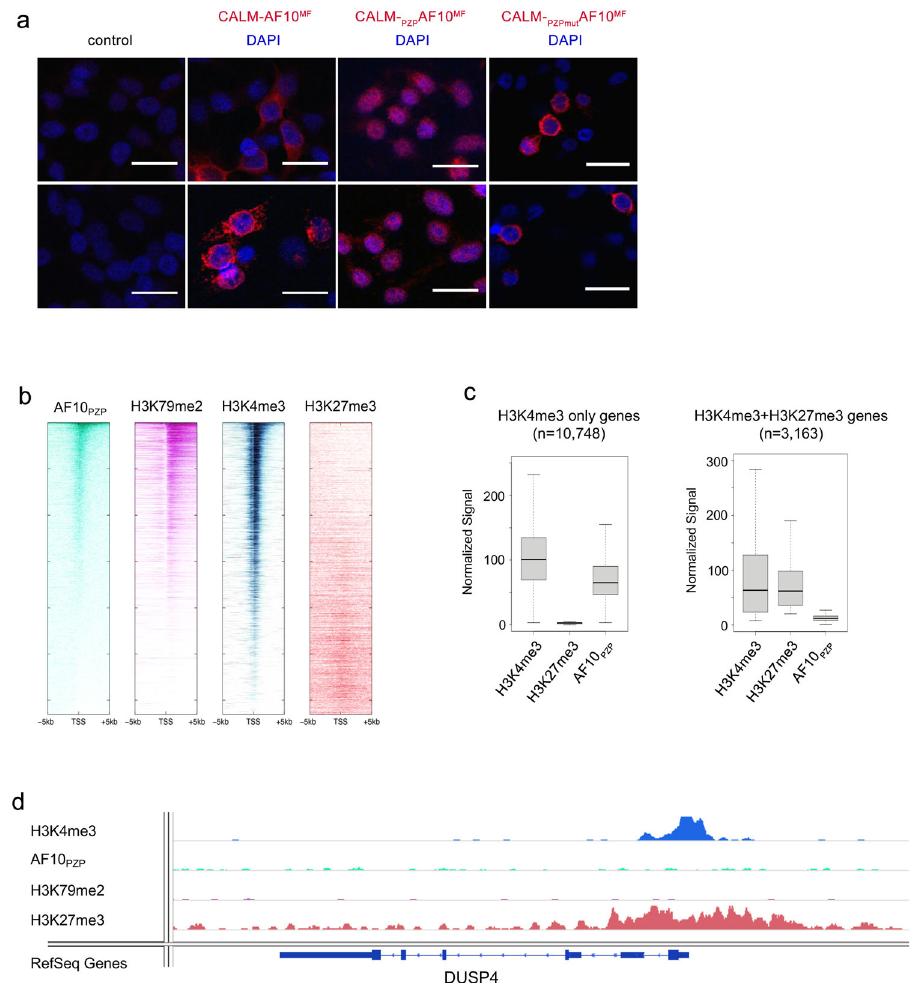
(red). DAPI (blue) was used for nuclear staining. Non-transfected cells were used as control. Scale bar, 20 µ m. ( n = 3) b Heatmaps showing AF10 PZP